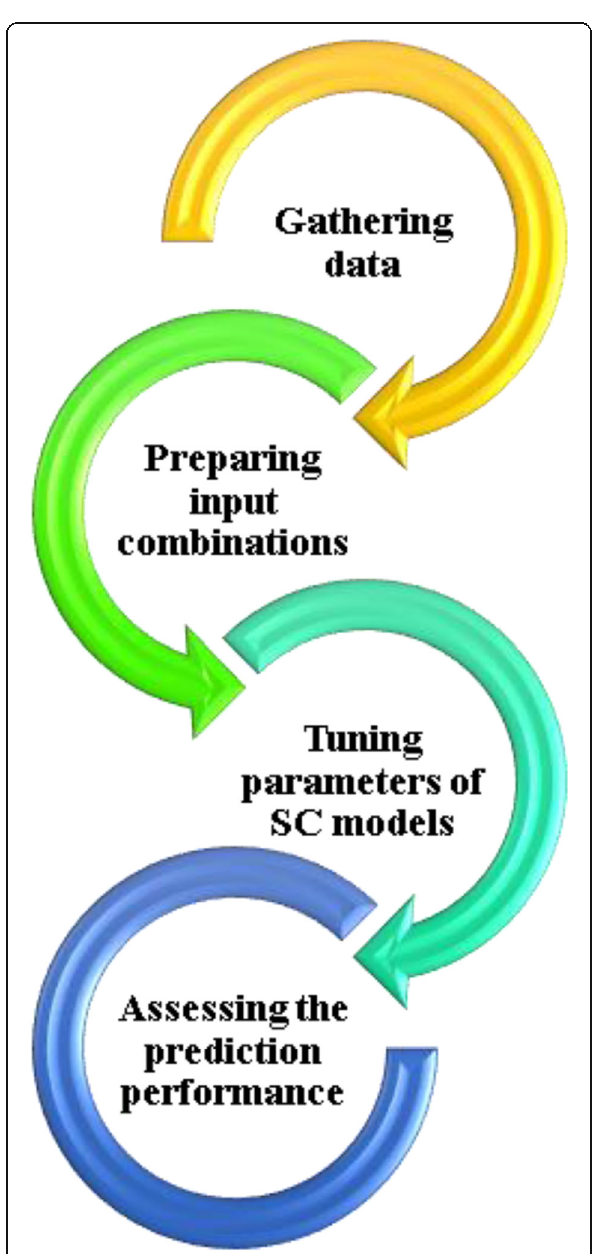
Fig. 1 Conceptual workflow of SC models for SST